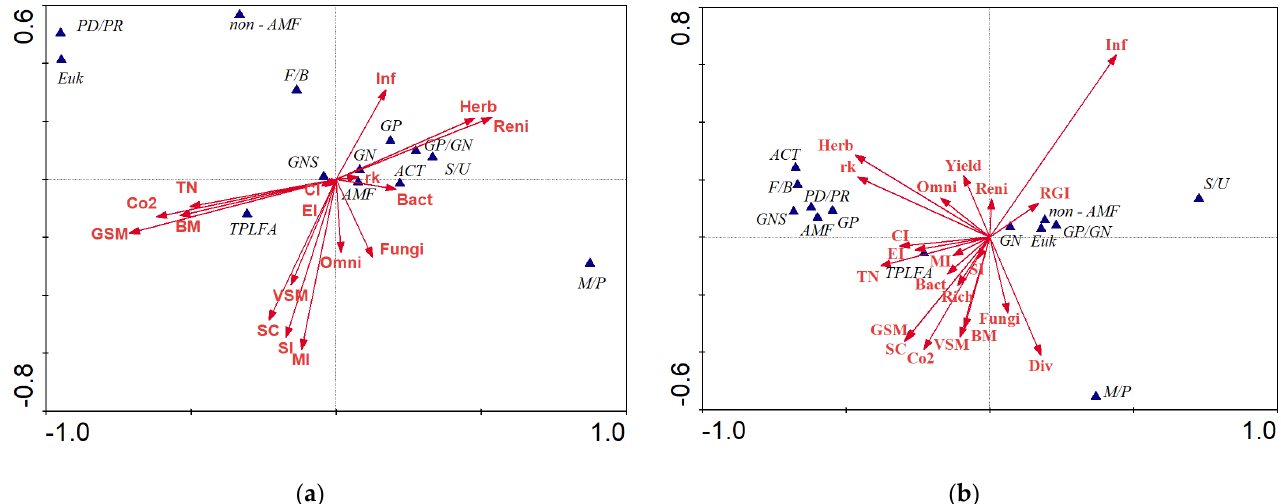
Figure 7. Canonical correspondence analysis (CCA) biplots showing the relationships among species variables (blue triangles) and environmental variables (red arrows) at ( a ) the time of cover crop termination and ( b ) at 3 months after eggplant planting. The first two axes explained 87.4% and 86% of the variation in the data in ( a , b ), respectively. The species variables include total phospholipid fatty acid (TPLFA), arbuscular mycorrhizal fungi (AMF), Gram-negative bacteria (GN), Gram-positive bacteria (GP), actinomyces (ACT), eukaryotes (EUK), non-arbuscular mycorrhizal fungi (non-AMF), fungi/bacteria (F/B), predator/prey (PD/PR), Gram-positive bacteria/Gram-negative bacteria (GP/GN), saturated fatty acids/unsaturated fatty acids (S/U), monounsaturated fatty acids/polyunsaturated fatty acids (M/P), Gram-negative stress (GNS). Environmental variables include reniform nematode (Reni), root-knot nematode (rk), herbivores/PPNs (Herb), bacterivores (Bact), fungivores (Fungi), omnivores (Omni), nematode richness (Rich), nematode diversity (div), maturity index (MI), enrichment index (EI), structure index (SI), channel index (CI), soil infiltration rate (Inf), soil carbon (SC), eggplant yield (Yield), soil respiration (Co2), volumetric soil moisture (VSM), gravimetric soil moisture (GSM), SSgH tissue nitrogen (TN), SSgH biomass (BM), and root-gall index (RGI).